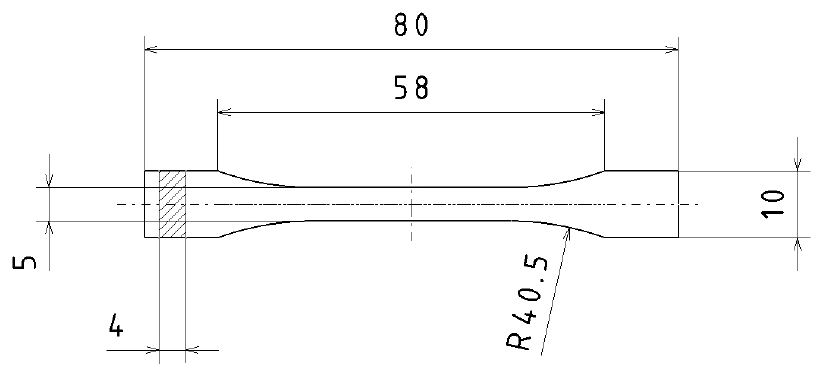
Figure 1. Schematic representation of the selected test rod. In order to save material, reduce costs, and reduce production time, the shape of